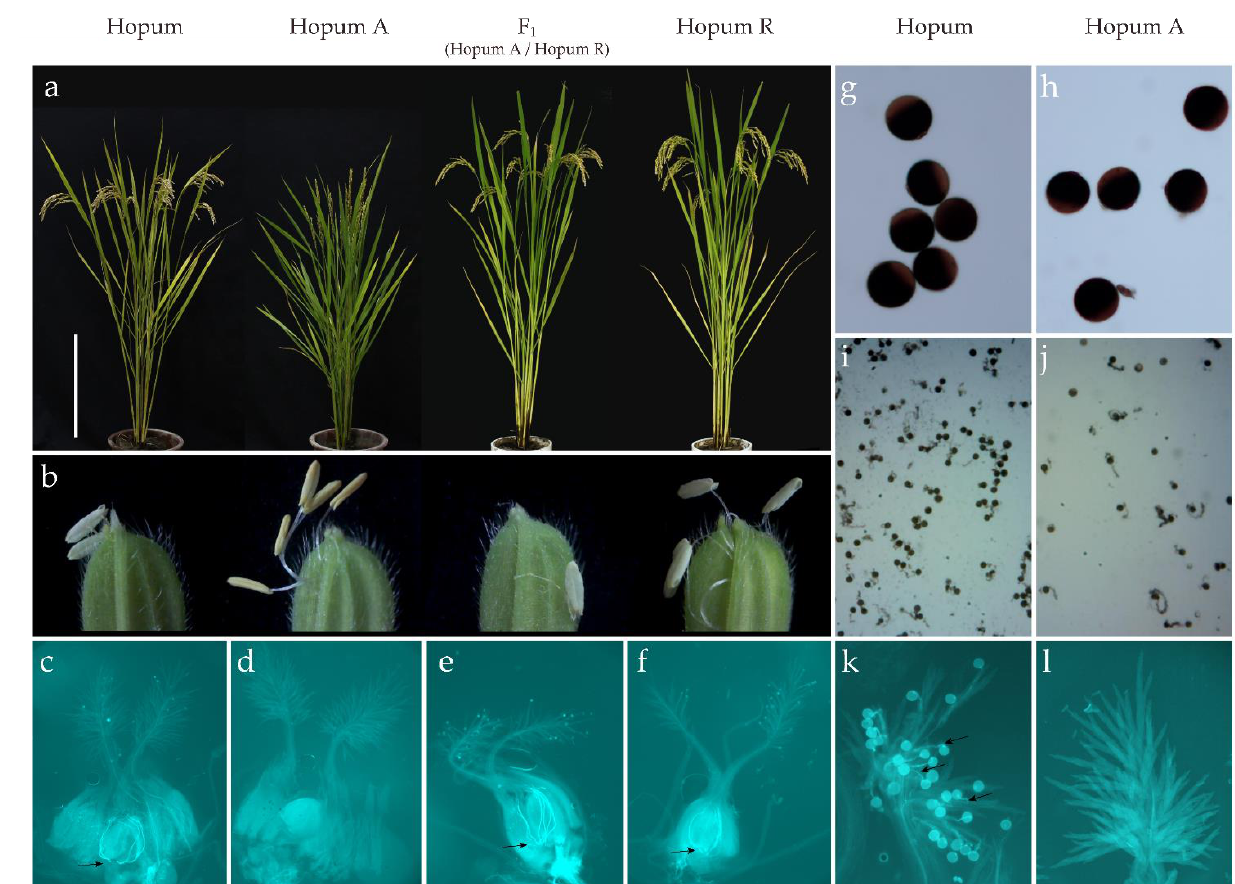
Figure 1. Phenotypes of plants. From left to right: Hopum, Hopum A, F 1 (Hopum A/Hopum R), Hopum R, Hopum, and Hopum A. ( a ) Plants before harvest. The scale bar = 30 cm; ( b ) spikelet and anthers after spikelet closure; ( c – f ) pollen tubes can be observed in the ovule, the black arrow point to pollen tubes; ( g , h ) pollen staining with I 2 -KI; ( i , j ) in vitro pollen germination with germination medium; ( k , l ) pollen tube growth on the stigma, the black arrows point to pollen tubes in ( k ). F 1 : derived from Hopum A/Hopum R.